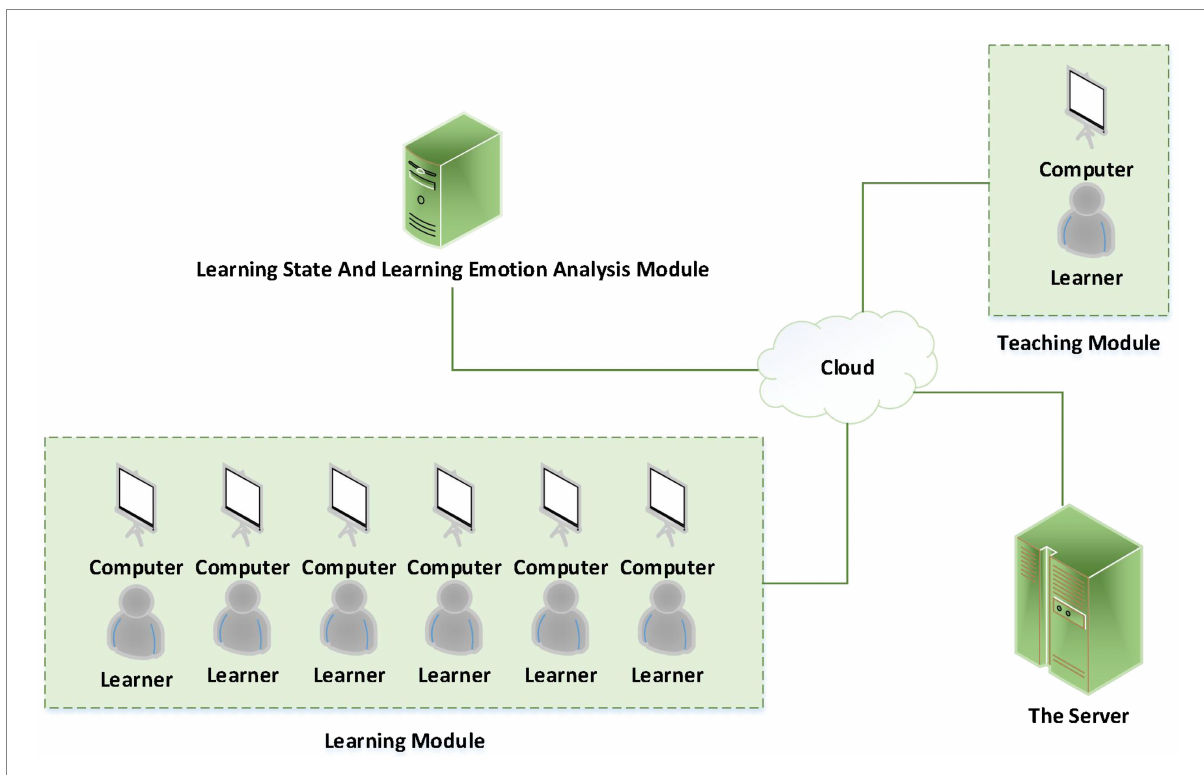
FIGURE 9 Deployment of emotion analysis module in network teaching